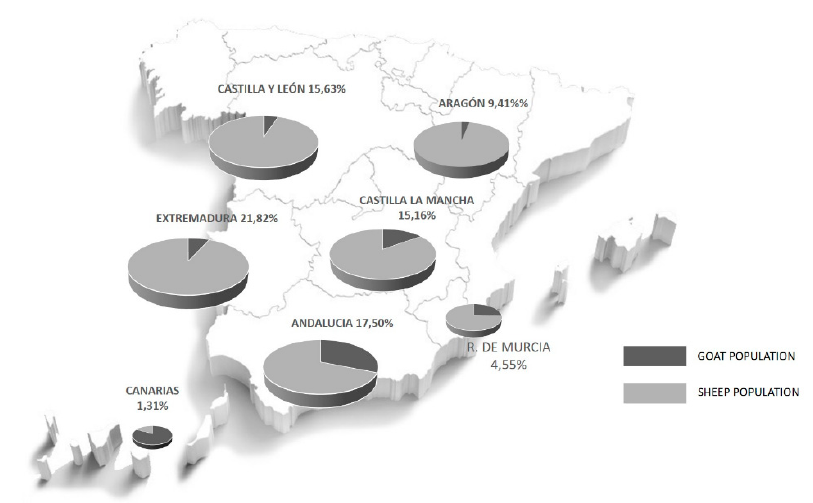
Figure1. Sheepandgoatpopulationsinthestudiedareas, Figure 1. Sheep and goat populations in the studied areas, involving over 80% of the total population [13].